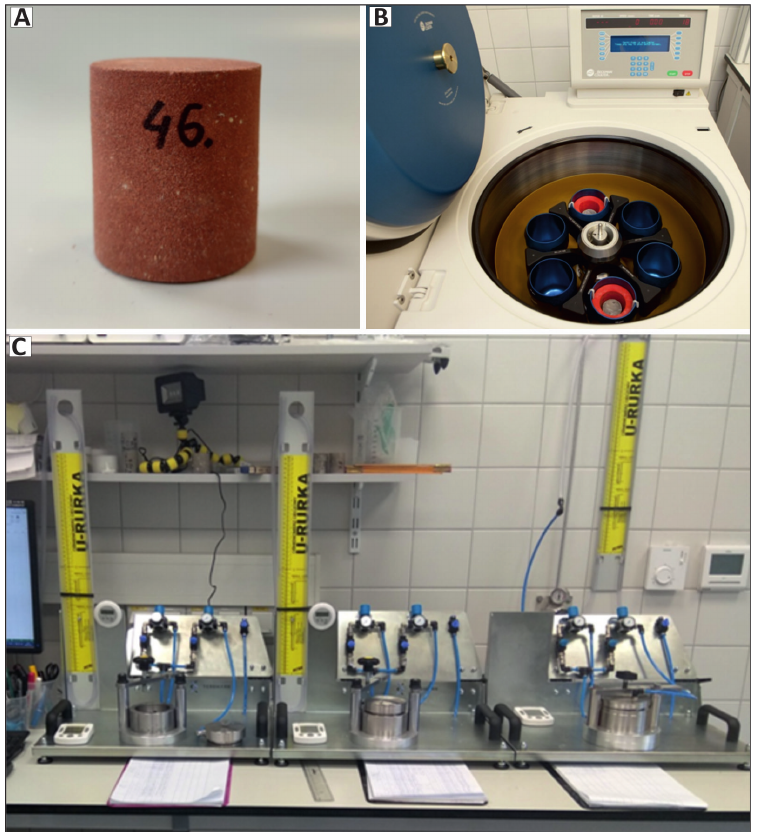
Figure 6. Core prepared for parameter determination ( A ), samples placed in a high-speed cen- trifuge ( B ), test equipment for measurement of k ( C